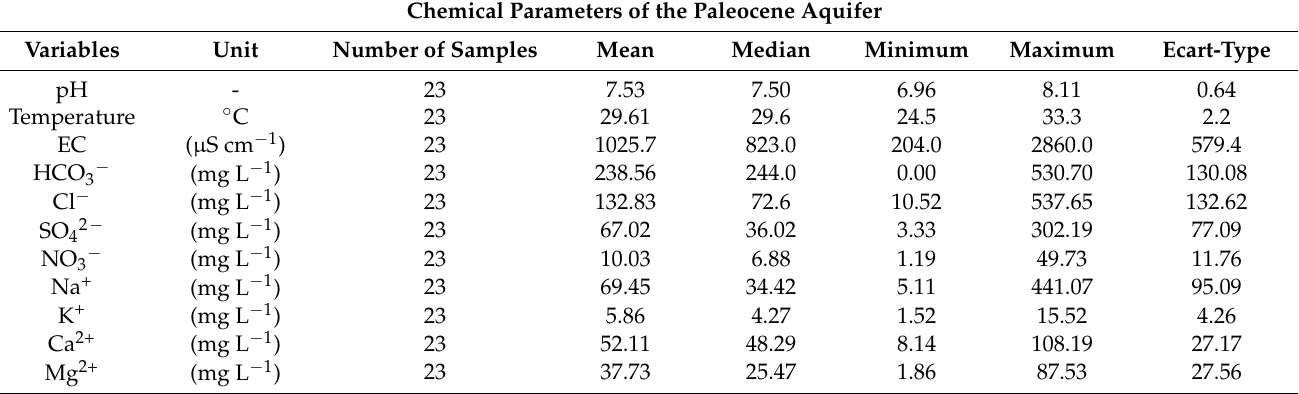
Table 2. Summary statistics of the Paleocene groundwater quality parameters measured in June 2019. Chemical Parameters of the Paleocene Aquifer